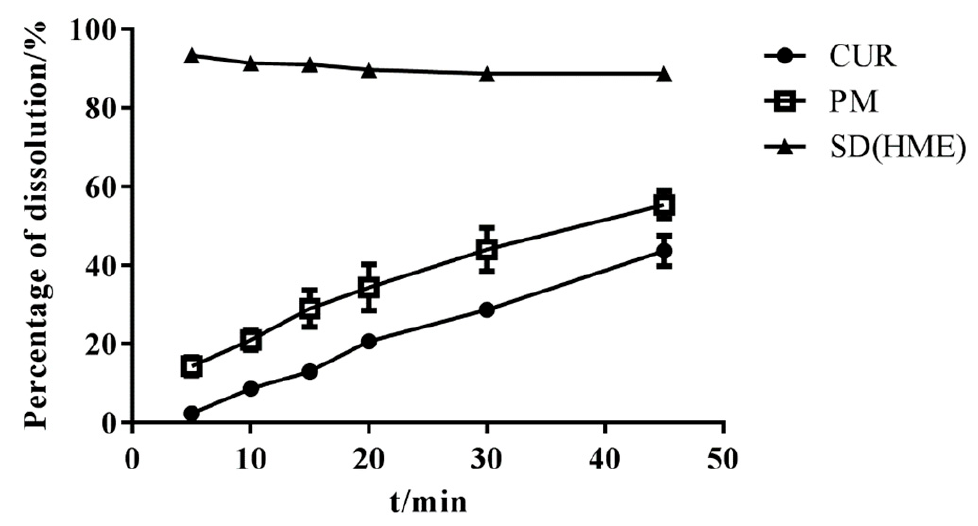
Figure 10. The dissolution of samples (n = 3).